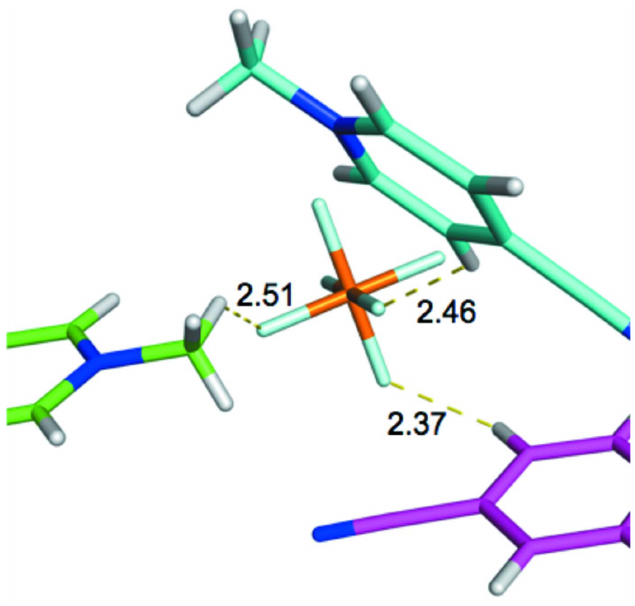
Figure 13 4-CMP + (cid:2)(cid:2)(cid:2) PF 6 (cid:3) interactions. BLYP-D3/def2-TZVP/SMD interaction energies (kcal mol (cid:3) 1 ) for these complexes are: (cid:3) 16.7 (green), (cid:3) 15.3 (cyan), (cid:3) 14.2